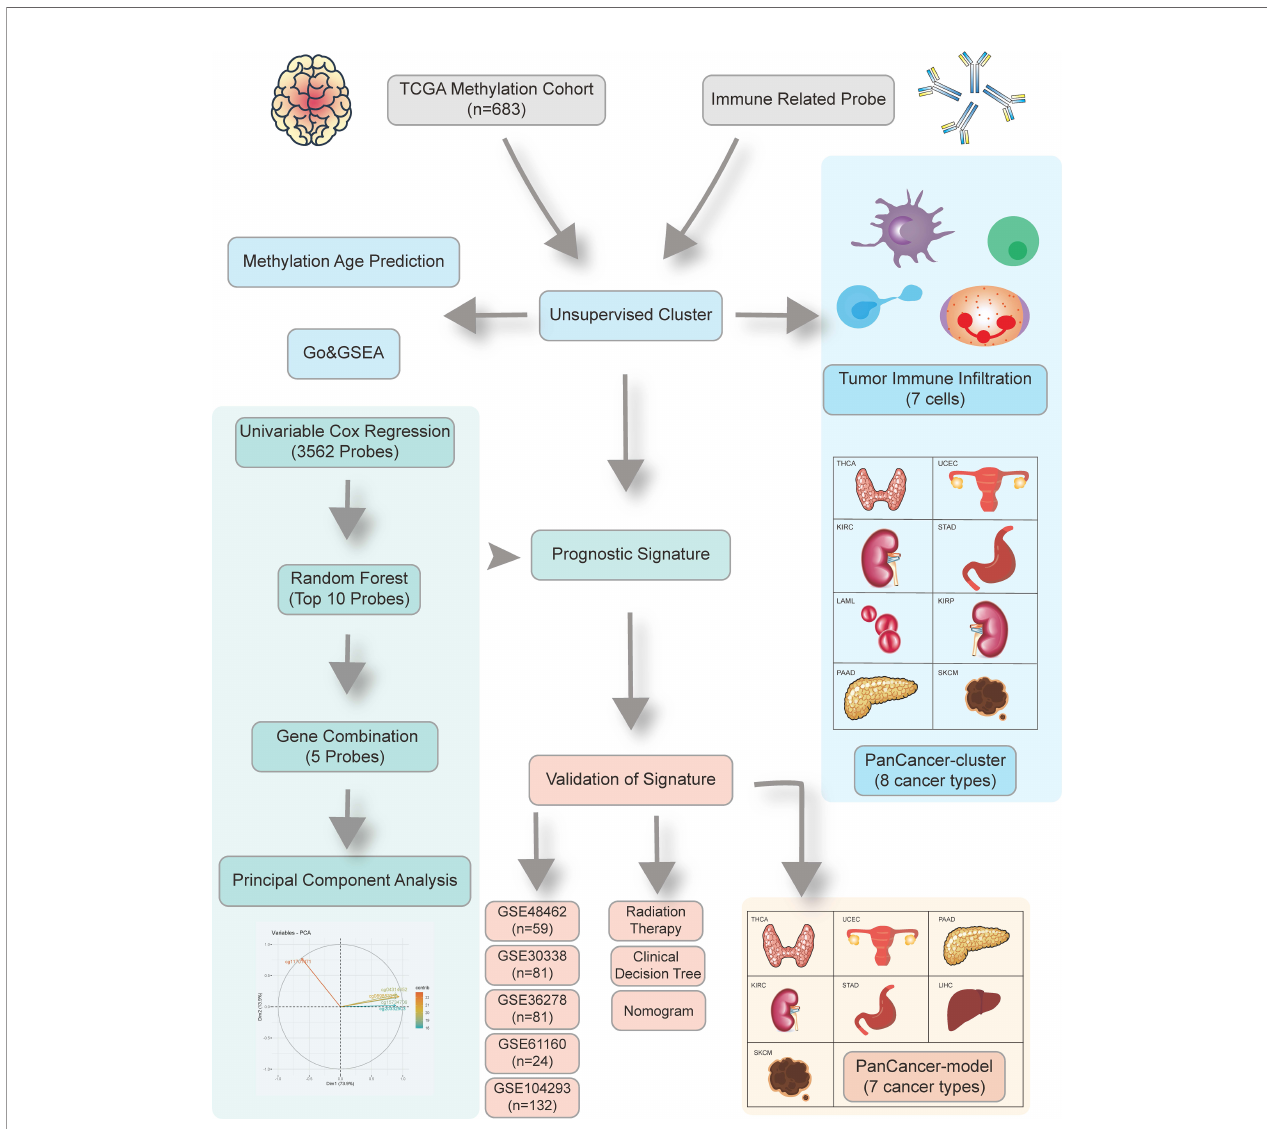
FIGURE 1 | Overview of the study design. First, we identi fi ed 24,556 candidate immune-related methylation probes. Then unsupervised cluster was used in a 683 TCGA glioma methylation cohort. A fi ve-CpG-based prognostic signature was established and validated in fi ve independent GEO